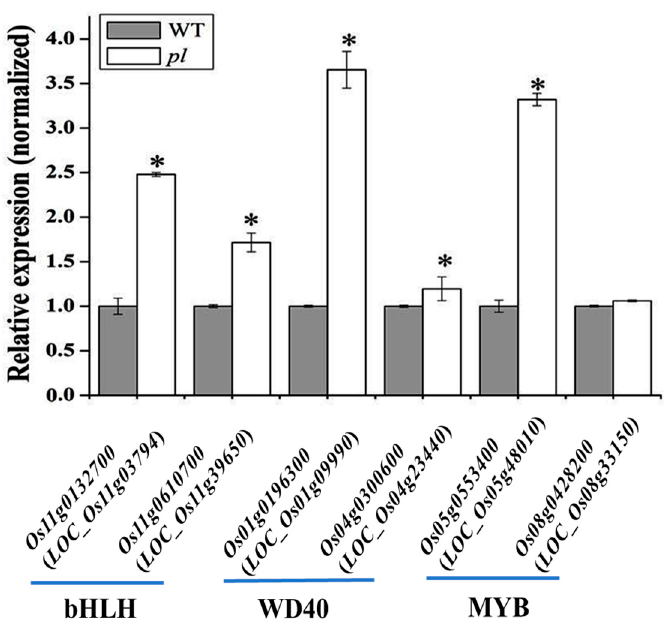
Figure 8. Expression of the transcription factor genes in anthocyanin biosynthesis in pl leaf as compared to the WT leaves. * indicates significant difference at p ≤ 0.05.